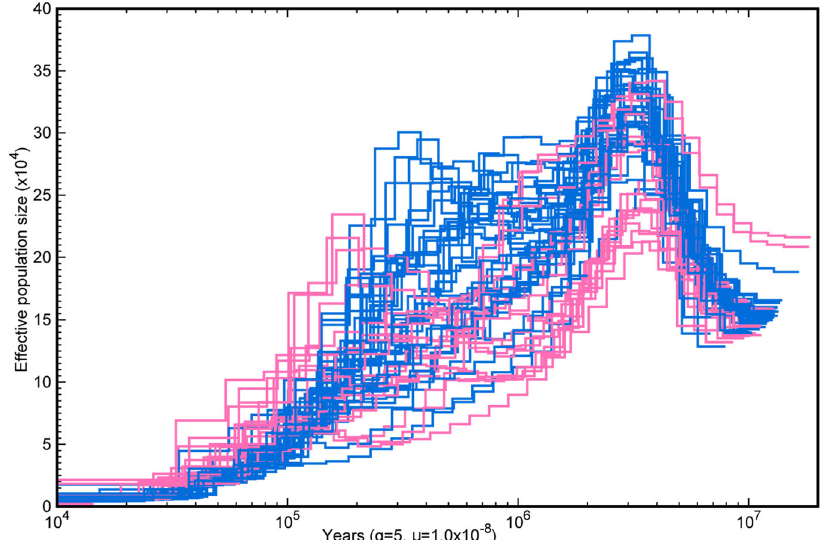
Fig. 4 | Genomic palaeodemography of Syzygium accessions from the S. grande group. Pairwise Sequentially Markovian Coalescent analyses, coloured by groups/ clades in Fig. 3. Source data are provided as a Source Data fi